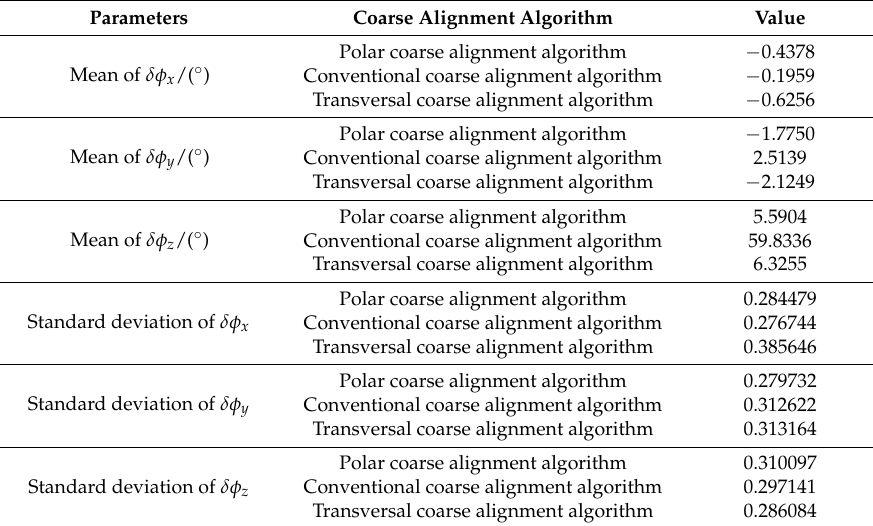
Table 5. The experiment results of coarse alignments.